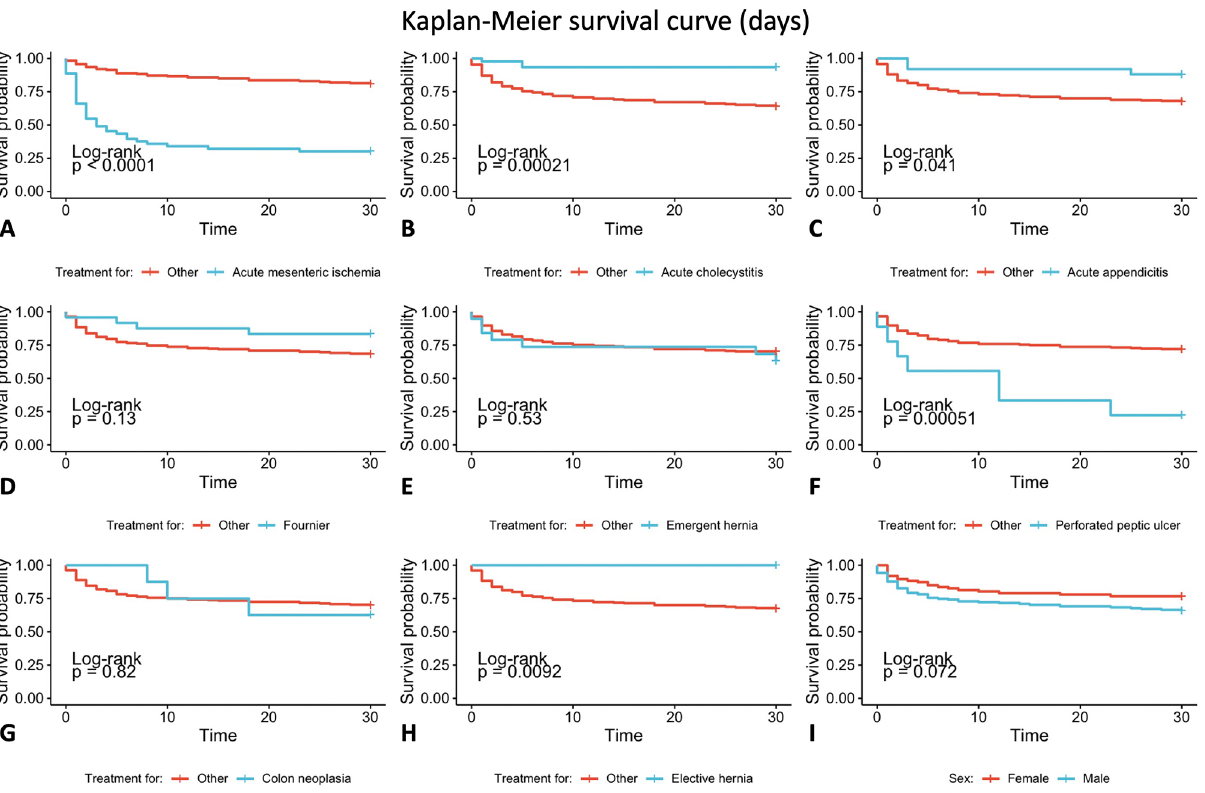
Figure 1. 30-day survival curve in patients with the most common diagnoses and comparison with treatment for other diagnoses. ( A ) Acute mesenteric ischemia. ( B ) Acute cholecystitis. ( C ) Acute appendicitis. ( D ) Fournier. ( E ) Emergent hernia. ( F ) Perforated peptic ulcer. ( G ) Colon neoplasia. ( H ) Elective hernia. ( I ) Overall mortality comparison between